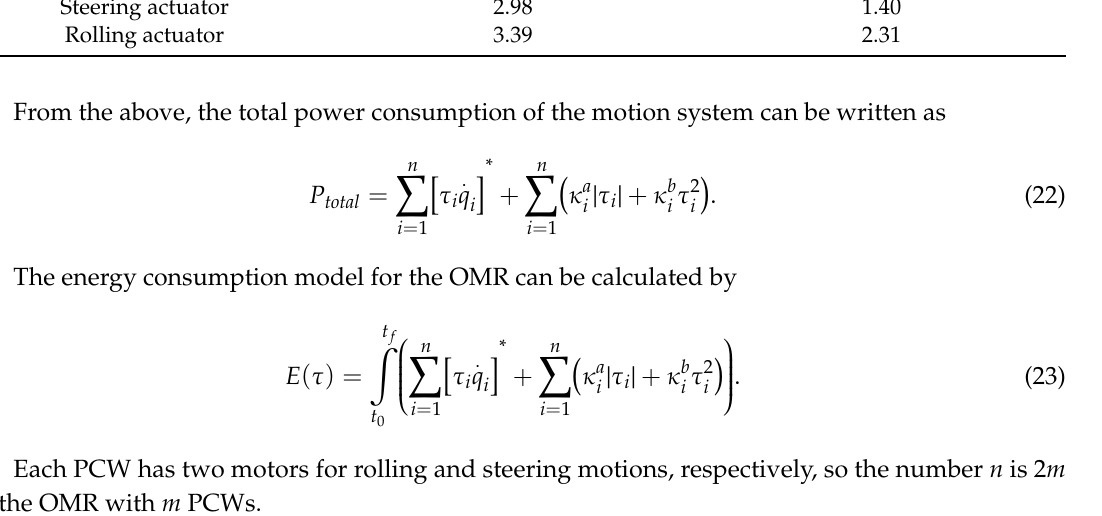
Figure 6. Experimental results of the electrical power loss: ( a ) function fitting for the rolling motor; ( b ) function fitting for the steering motor. Table 1. Experimental results for the coe ffi cients of the power loss model. Class of